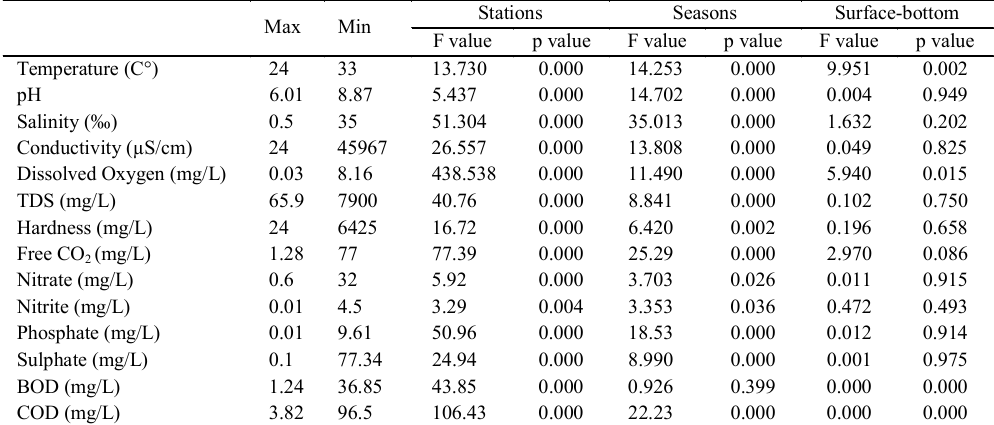
Table 1: ANOVA of water quality parameters of Veli-Akkulam and Vellayani Lakes at significant level (p-value <0.05) Stations Max Min